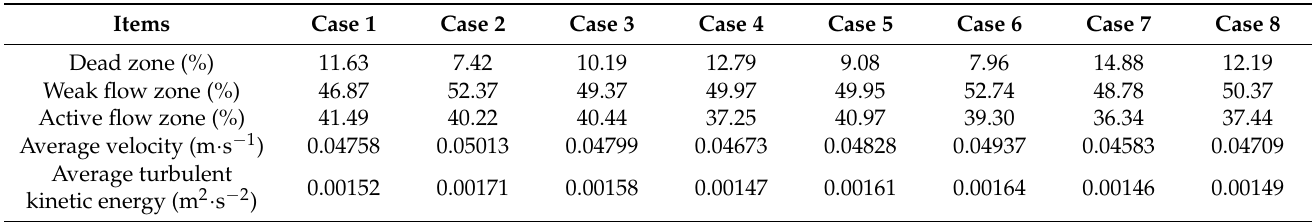
Table 3. Distribution of molten steel velocity interval distribution ratio, average velocity, and average turbulent kinetic energy in the eight